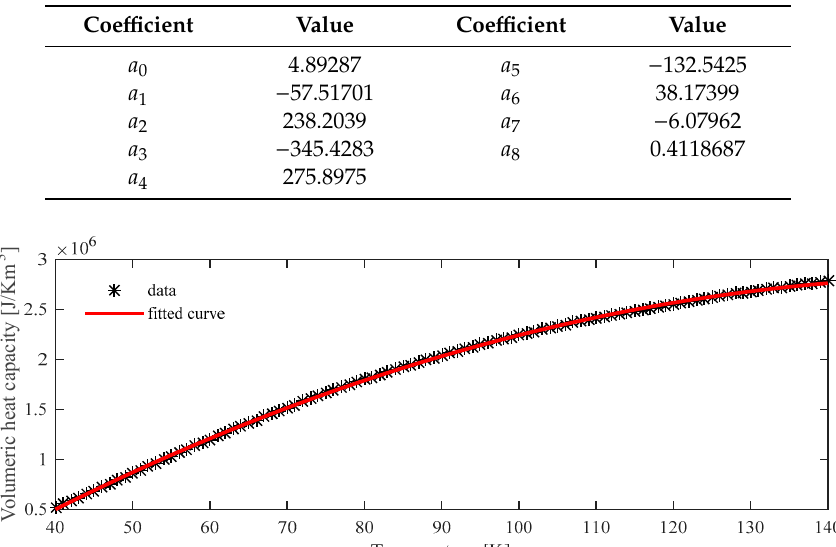
Table 1. Coe ffi cients of the copper heat capacity.